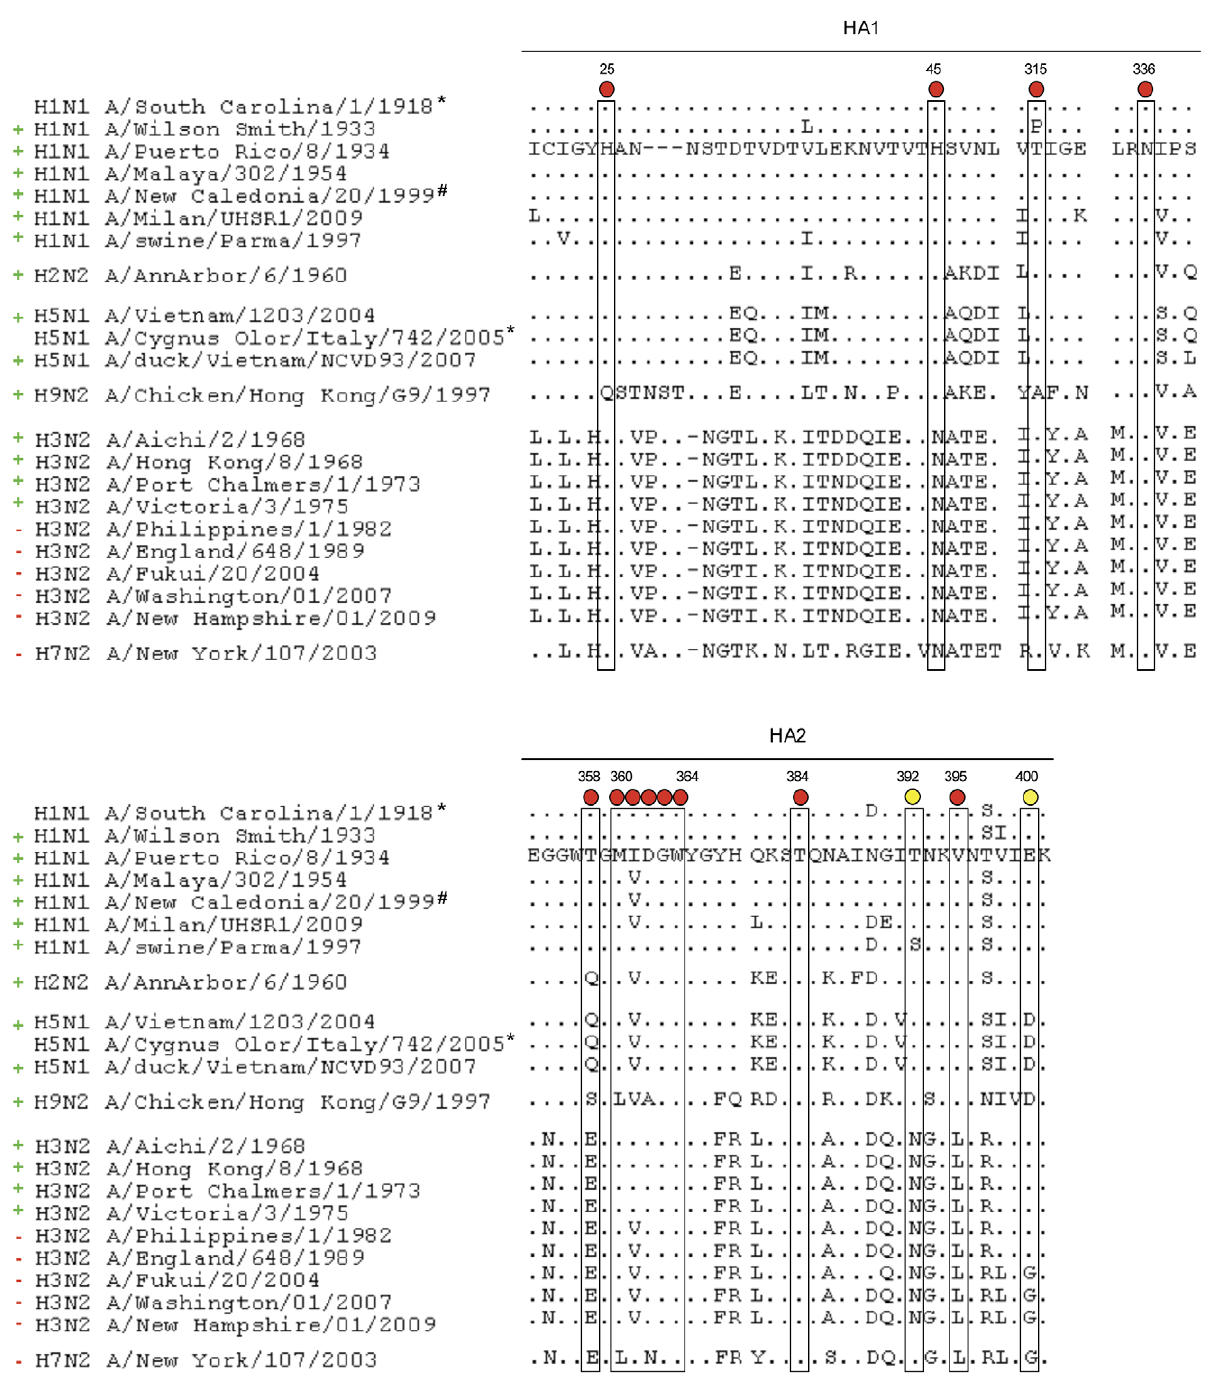
Figure 2. Sequence conservation in hemagglutinin groups and subtypes. Boxes indicate mutated residues which decrease PN-SIA28 binding to mutated HAs. Circles on the top indicate PN-SIA28 percent binding to each HA alanine mutants compared to binding to wild-type HA: red 25% binding, yellow 50–75% binding. Sequence numbering is based on H1N1 A/PR/8/34 coding region (GenBank accession number ABO21709). Neutralizing activity of PN-SIA28 against each strain is highlighted by a green ‘ + ’ or a red ‘ 2 ’ on the left, indicating neutralizing activity and no neutralizing activity, respectively. *Recombinant HA from H1N1 A/South Carolina/1/1918 pandemic strain was previously shown to be bound by PN- SIA28 [19,20]; analogously, recombinant HA from H5N1 A/Cygnus Olor/Italy/742/2005 was recognized by PN-SIA28 (data not shown). # H1N1 A/New Caledonia/20/1999 was previously shown to be neutralized by PN-SIA28 as Fab fragment [19,20]. doi:10.1371/journal.pone.0028001.g002 robust neutralizing activity (IC 50 = 0.4–3.7 m g/ml) against all highly divergent H9 subtype. More importantly, PN-SIA28 tested strains belonging to group 1, thus demonstrating that its showed a potent neutralizing activity also against group 2 viruses epitope is broadly shared among group 1 viruses, including the demonstrating that its epitope is also present in the highly